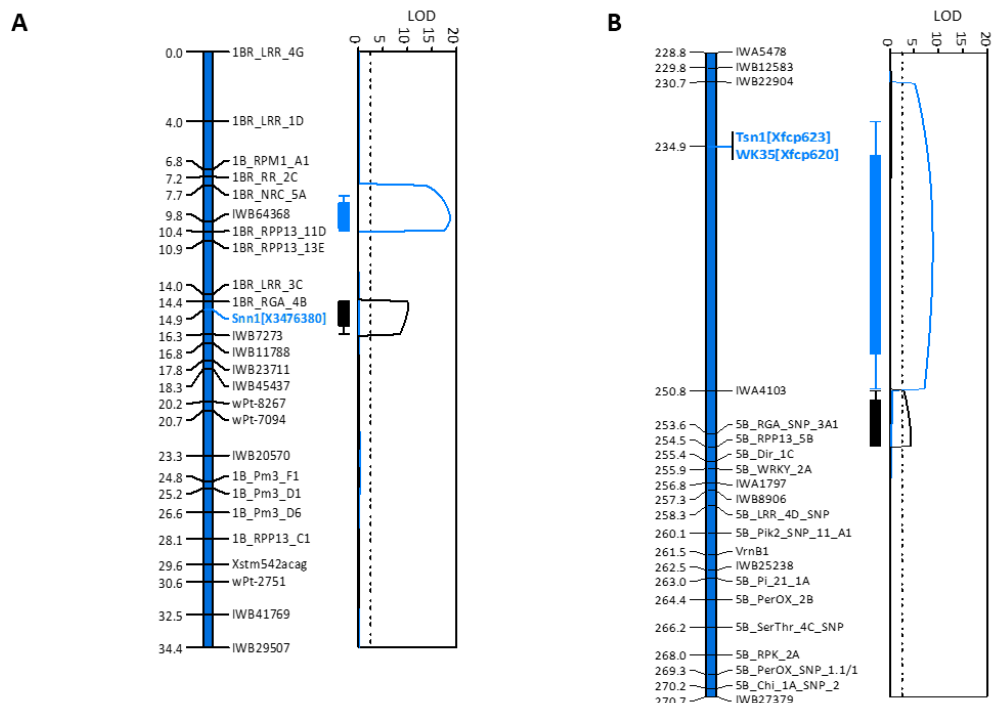
Figure 2. Genetic map of R -gene markers developed in this study integrated with genetic map of SNP and other markers [33] for chromosomes ( A ) 1BS and ( B ) 5BL. Markers for Snn1 , Tsn1 and WK35 genes are highlighted in blue. QTL traces with corresponding LOD scores for foliar disease scores in 2007 (blue bar and lines) and in 2008 (black bar and lines) on 1BS and 5BL as previously reported [33] are shown to the right of each figure. Table 2. One-dimension scanning positions of R -gene markers associated with QTL for SNB resistance in a DH population derived from the cross of resistant and susceptible parents, EGA Blanco and Millewa, respectively. Gene markers with significant associations ( p < 0.001) are highlighted in grey